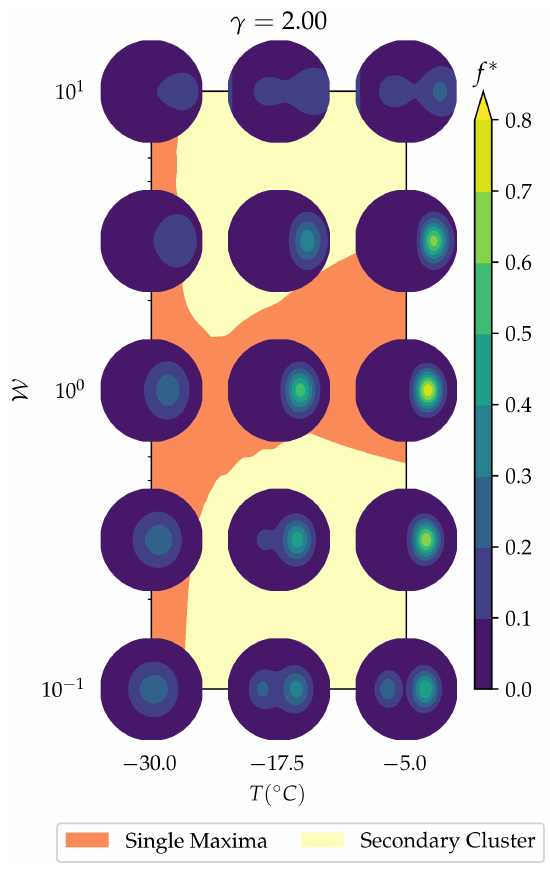
Figure 12. Pole figures overlaid onto the regimes at γ = 2. The pole figures are centred at the vorticity number and temperature they